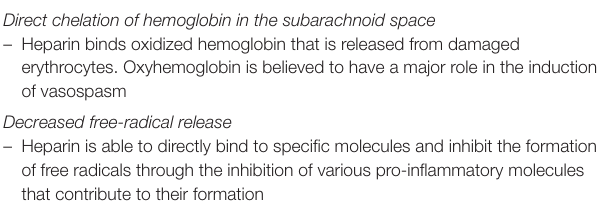
of free radicals through the inhibition of various pro-inflammatory molecules that contribute to their formation Inhibition of endothelin-1 (ET-1) – Inhibition of mRNA transcription of ET-1 – Inhibition of transactivation of the epidermal growth factor receptor by binding of heparin to the specific ligand